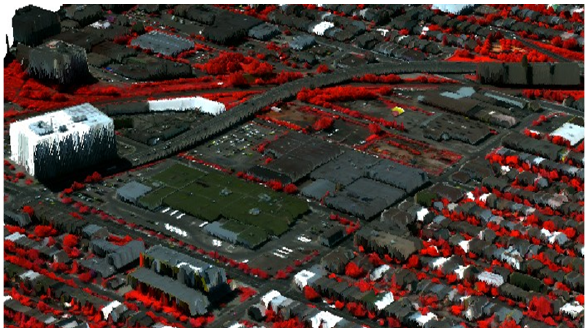
Figure 4. ITRES produced orthorectified images based on